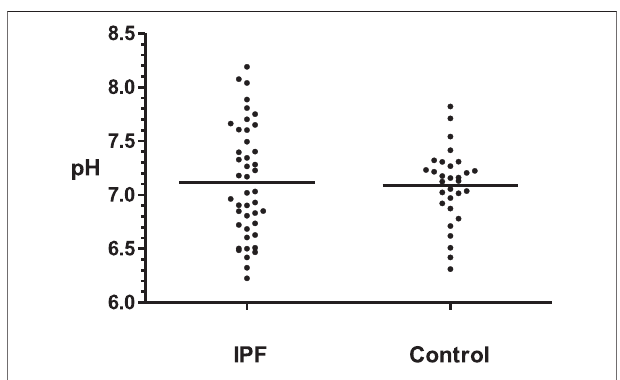
FIGURE 2 | Overall mean laryngopharyngeal pH values of IPF and control groups Control: healthy individuals. IPF (cid:1) idiopathic pulmonary fi brosis. The overall average laryngopharyngeal pH of two groups were similar (IPF: 7.11 vs Control 7.09, p > 0.05, Kruskal-Wallis test).